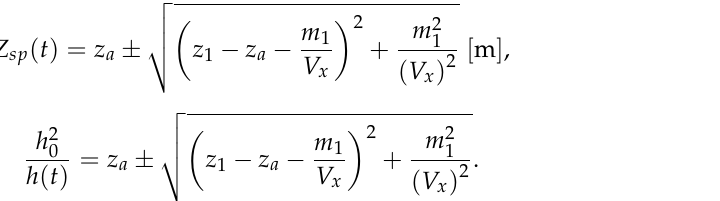
Figure A8. Rankine oval and definition of half width h and source-sink spacing 2 b . [86].